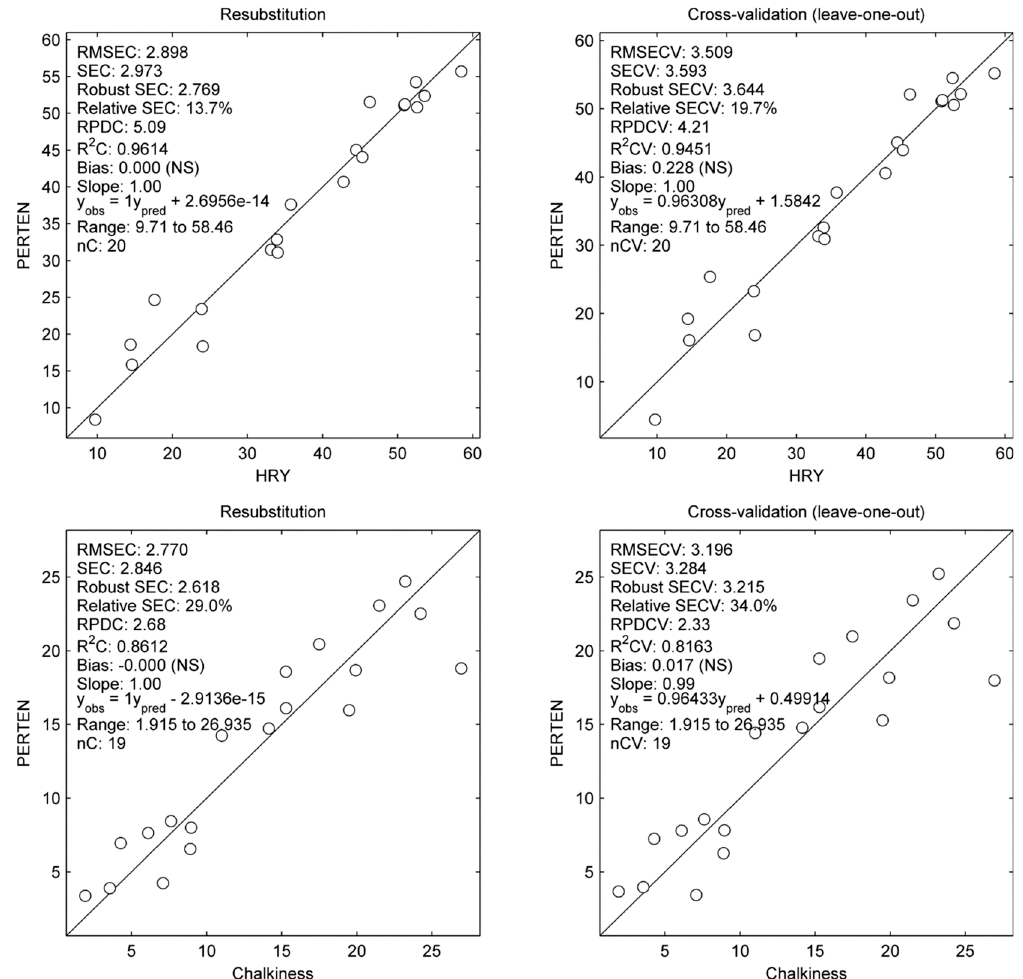
Figure 10. Observed vs. estimated HRY ( top row ) and Chalkiness ( bottom row ). The performances were estimated using re-substitution ( left column ) and leave-one-out (LOO) cross-validation ( right column ).